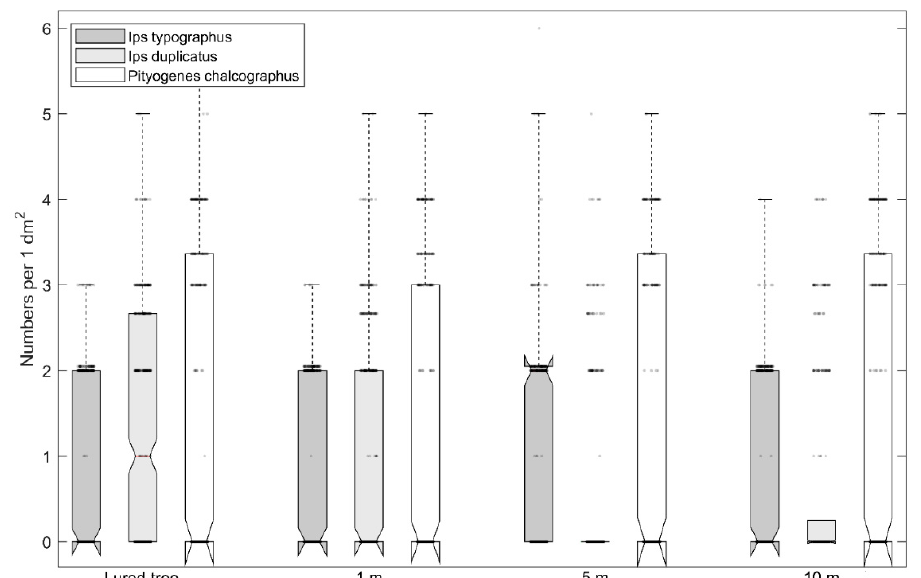
Figure 2. Numbers of Ips typographus, Ips duplicatus, and Pityogenes chalcographus maternal galleries on felled trap trees with branches and that had pheromone lures or that lacked pheromone lures; trees without lures were placed 1, 5, or 10 m away from lure trees (notch-median; box plot—25% and 75% values; dotted line: minimum–maximum without extremes; circles: values). The notch depth represents the confidence interval.